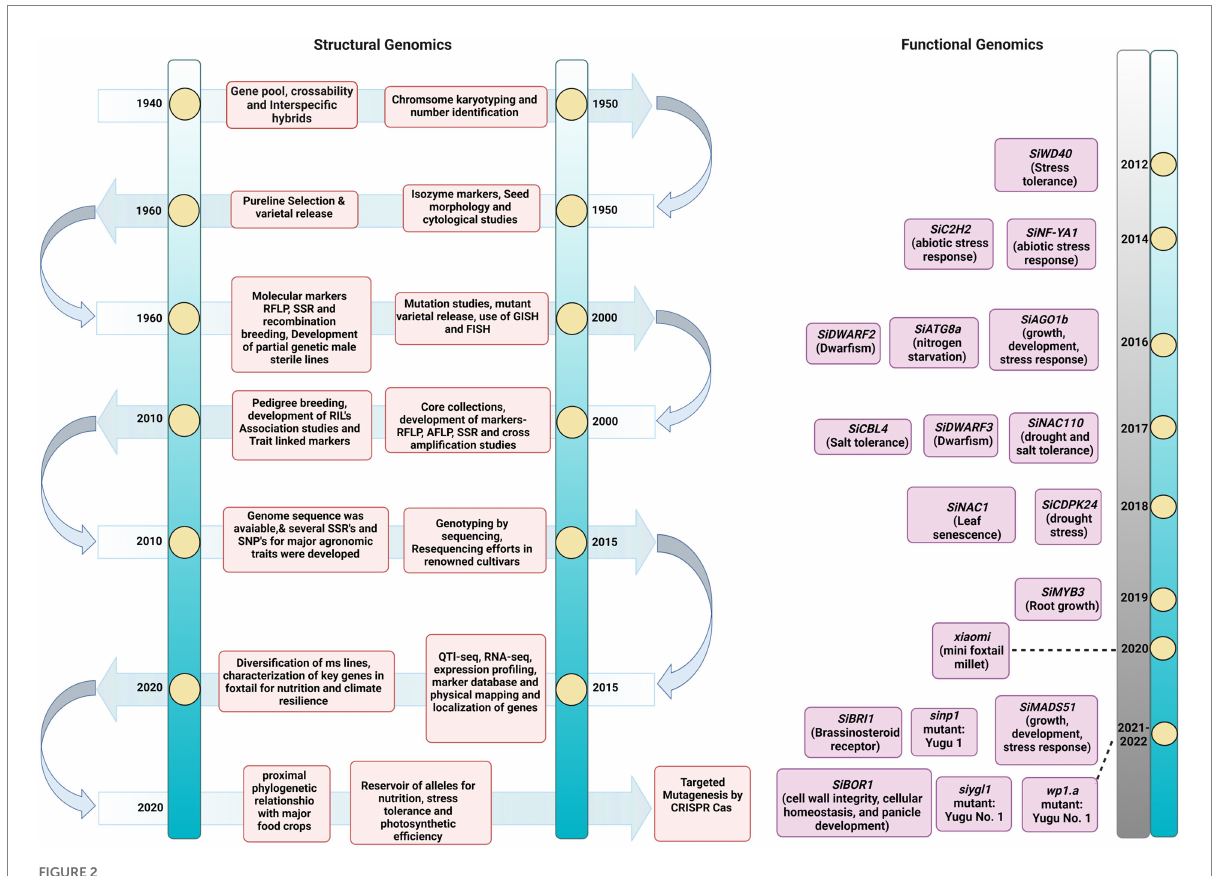
FIGURE 2 Timeline of advances in Setaria omics pre- and post-genome sequence release. The timeline of events in the breeding and genomics efforts completed for Setaria . The figure describes the significant achievements in classical and modern